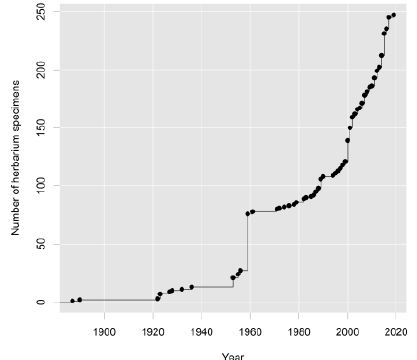
Figure 1. Temporal pattern in herbarium specimen collection.